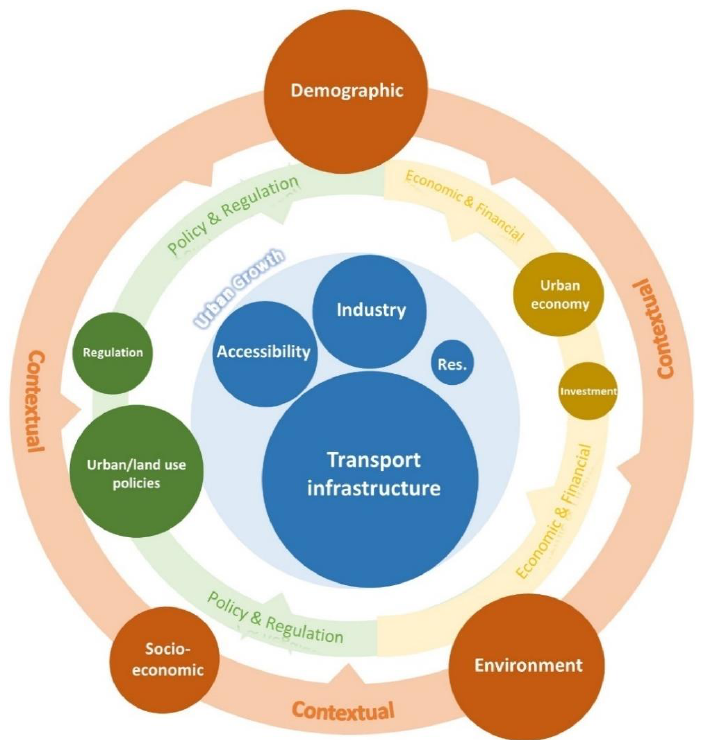
Figure 5. Driving forces causing LULCC, their frequency and interrelations.